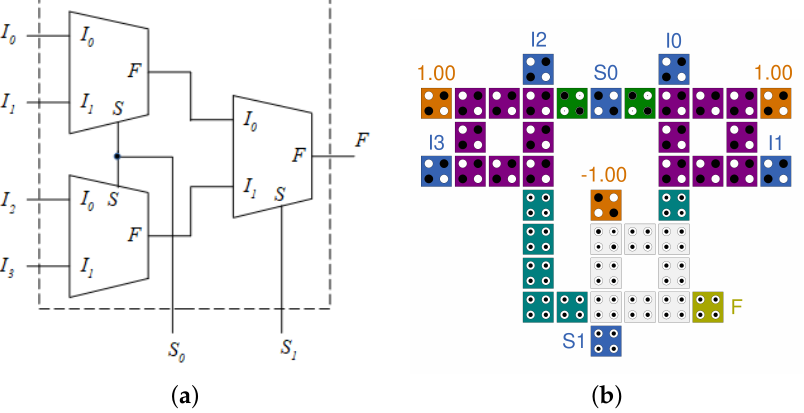
Figure 3. 4 × 1 MUX using 2 × 1 MUXes: ( a ) Abstract diagram; ( b ) QCA